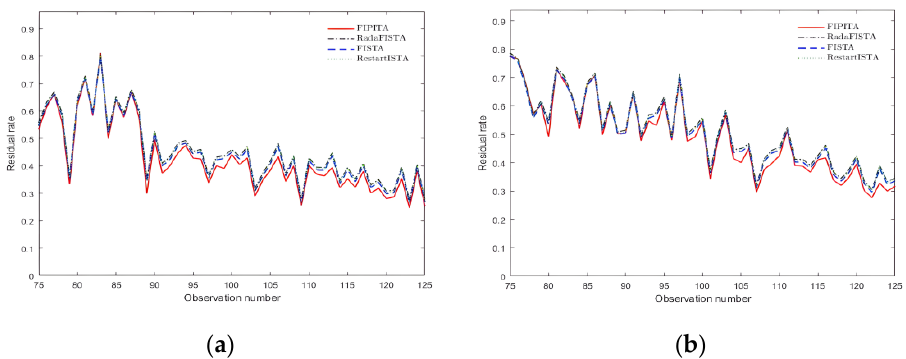
Figure 8. Signal residual rate under different observation numbers. ( a ) Residual rate of Hadamard matrix; ( b ) residual rate of Gaussian matrix.